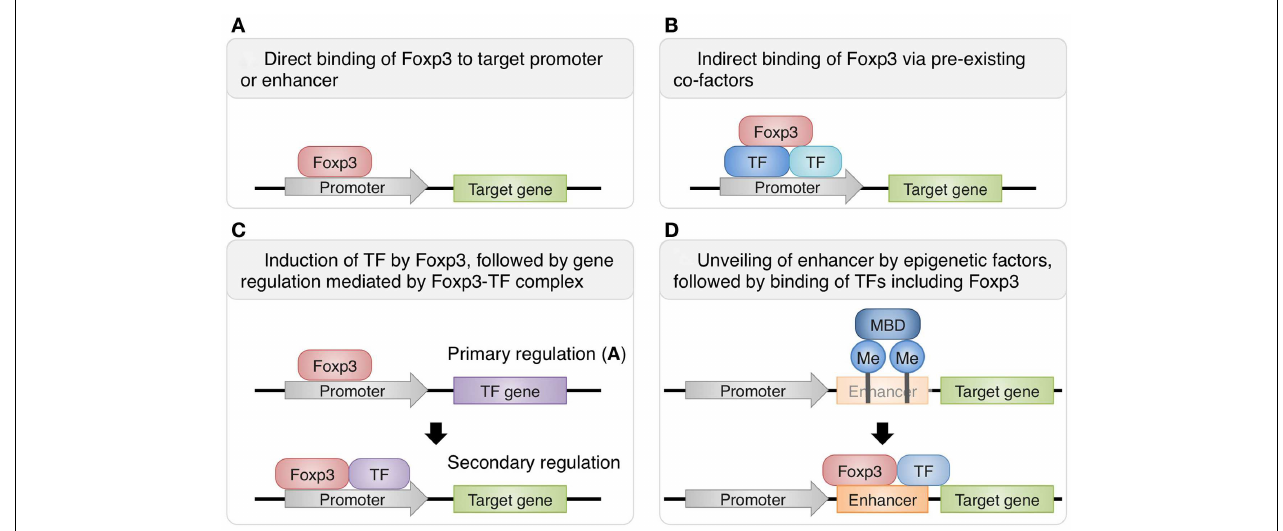
gene regulation, such as GATA-3 (C) (Rudra et al., 2012). Furthermore, there are also genes regulated by both Foxp3 and epigenetic changes. For example, at Foxp3 locus, epigenetic modifications unveil normally hidden enhancer and allow the transcriptional activation by Foxp3 and its co-factors (D) (Floess et al., 2007; Schmidl et al., 2009; Zheng et al.,